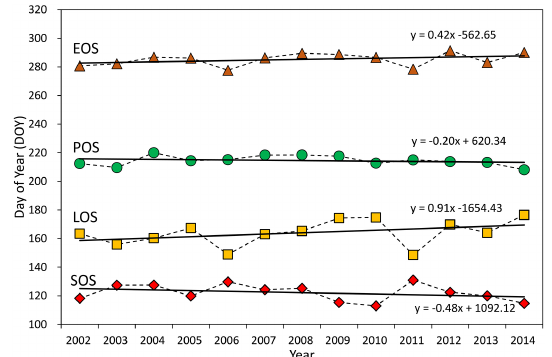
Figure 6. The trend of phenology dates from 2002 to 2014. SOS is the start of growing season; POS is the maximum NDVI date during the growing season; EOS is the date of the end of season; LOS is the length of growing